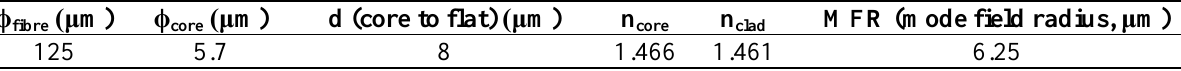
Table 1. Measured parameters of the